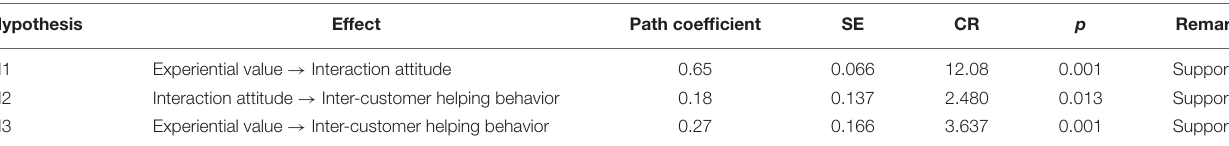
FIGURE 2 | Results of the structural equation model. TABLE 7 | Hypothesis testing results.